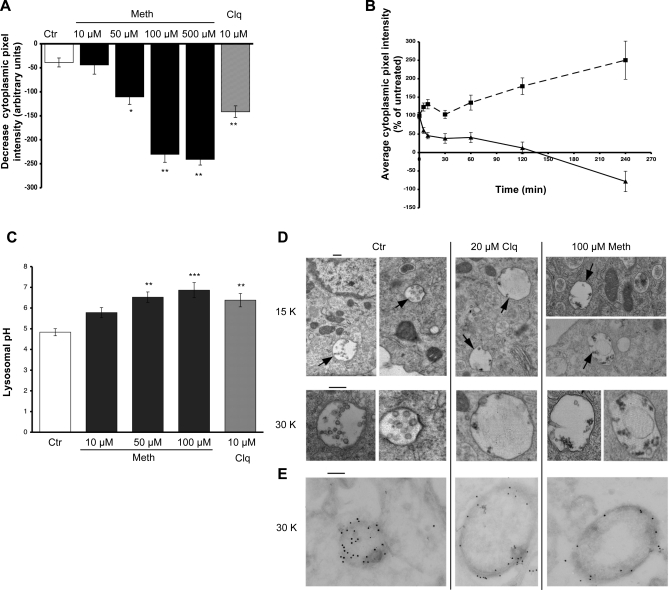
Meth Induces Rapid Alkalization of Acidic Organelles, and Changes in Endosomal Structure in Dendritic Cells(A) Morphometric analysis of the decrease in acridine orange staining after 10 min treatment. Similar results were obtained in three independent experiments. (Statistics n = 25–35, mean ± SEM, **p < 0.001, ***p < 0.0001, two-tailed ANOVA.)(B) Progressive quenching of cytosolic acridine orange staining over 4 h in the absence () or presence (▴) of 50 μM Meth. p < 0.001 for all time points versus control (n = 25–35, mean ± SEM, Student's two-tailed t-Test).(C) Acidic organelle pH in cells exposed to Meth for 10 min measured by ratiometric measurement. (Statistics n = 30–90 cells, mean ± SEM, **p < 0.001, ***p < 0.0001, two-tailed ANOVA.)(D) Representative electron micrographs showing multivesicular endosomal compartments (arrows) in control, Clq- and Meth-treated cells at 4 h. Scale bar, 200 nm. (E) Ultra-thin cryosections of control, Clq- and Meth-treated dendritic cells as in (D), immunolabeled for LAMP-1 (15 nm gold particles) and MHC class II (10 nm gold particles). Scale bar, 200 nm.